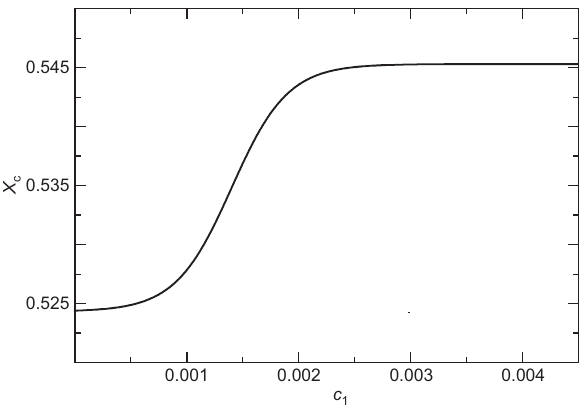
Figure 3 Flory parameter as a function of c χ = 0.524318, ε = 2000, and -3 min